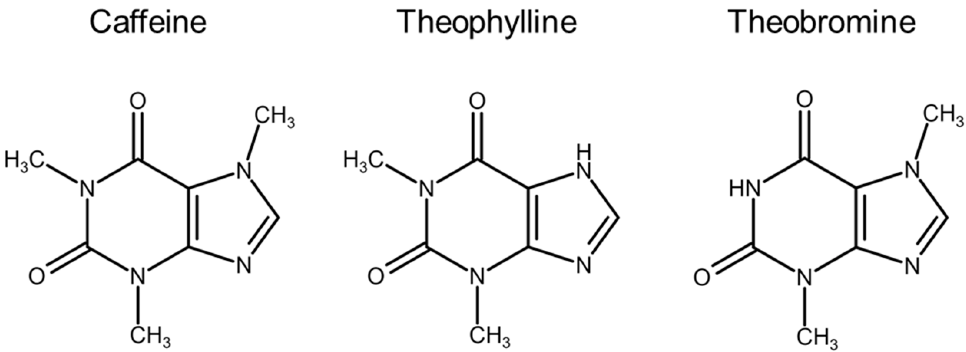
Figure 6. Chemical structure of methylxanthines: caffeine (1,3,7-trimethyl-), theophylline (1,3-dimethyl-) and theobromine (3,7-dimethyl-)xanthine.